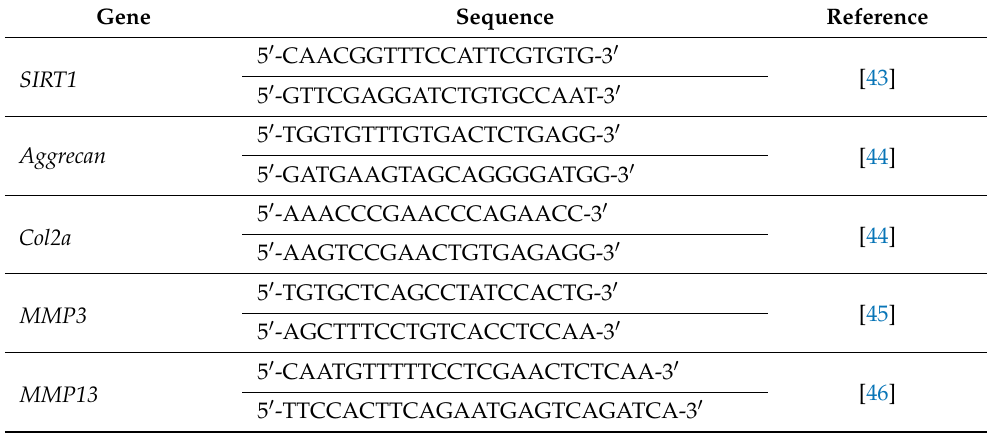
Table 1. Primers for PCR